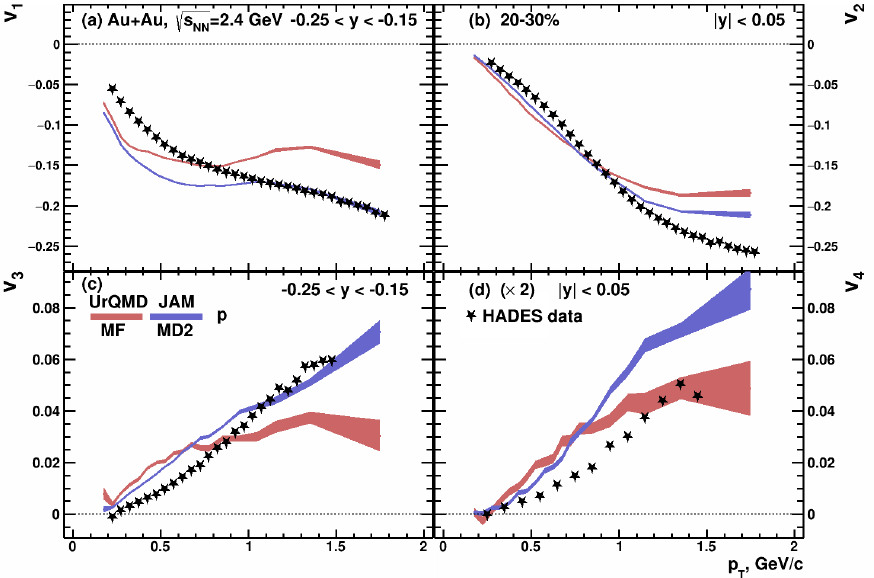
Figure 8. p T dependence of anisotropic flow coefficients v 1 , v 2 , v 3 and v 4 of protons ( a – d ) in the √ s NN = 2.4 GeV. The black closed symbols denote the published 20–30% central Au + Au collisions at data from the HADES experiment [17]. The red and blue bands represent the results from the mean- field mode of UrQMD and JAM MD2 models, respectively. The uncertainties of the simulated model data are